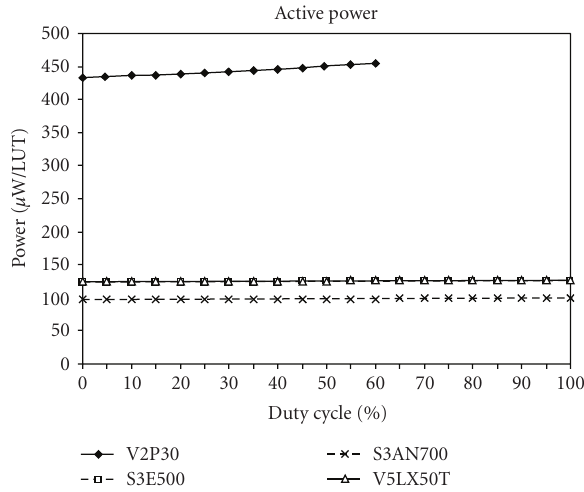
Figure 3: Variation of device surface temperature with duty cycle.